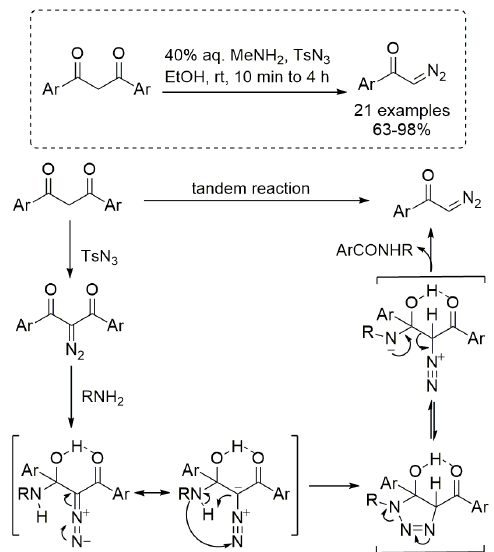
Figure 22 - A tandem reaction synthesis of